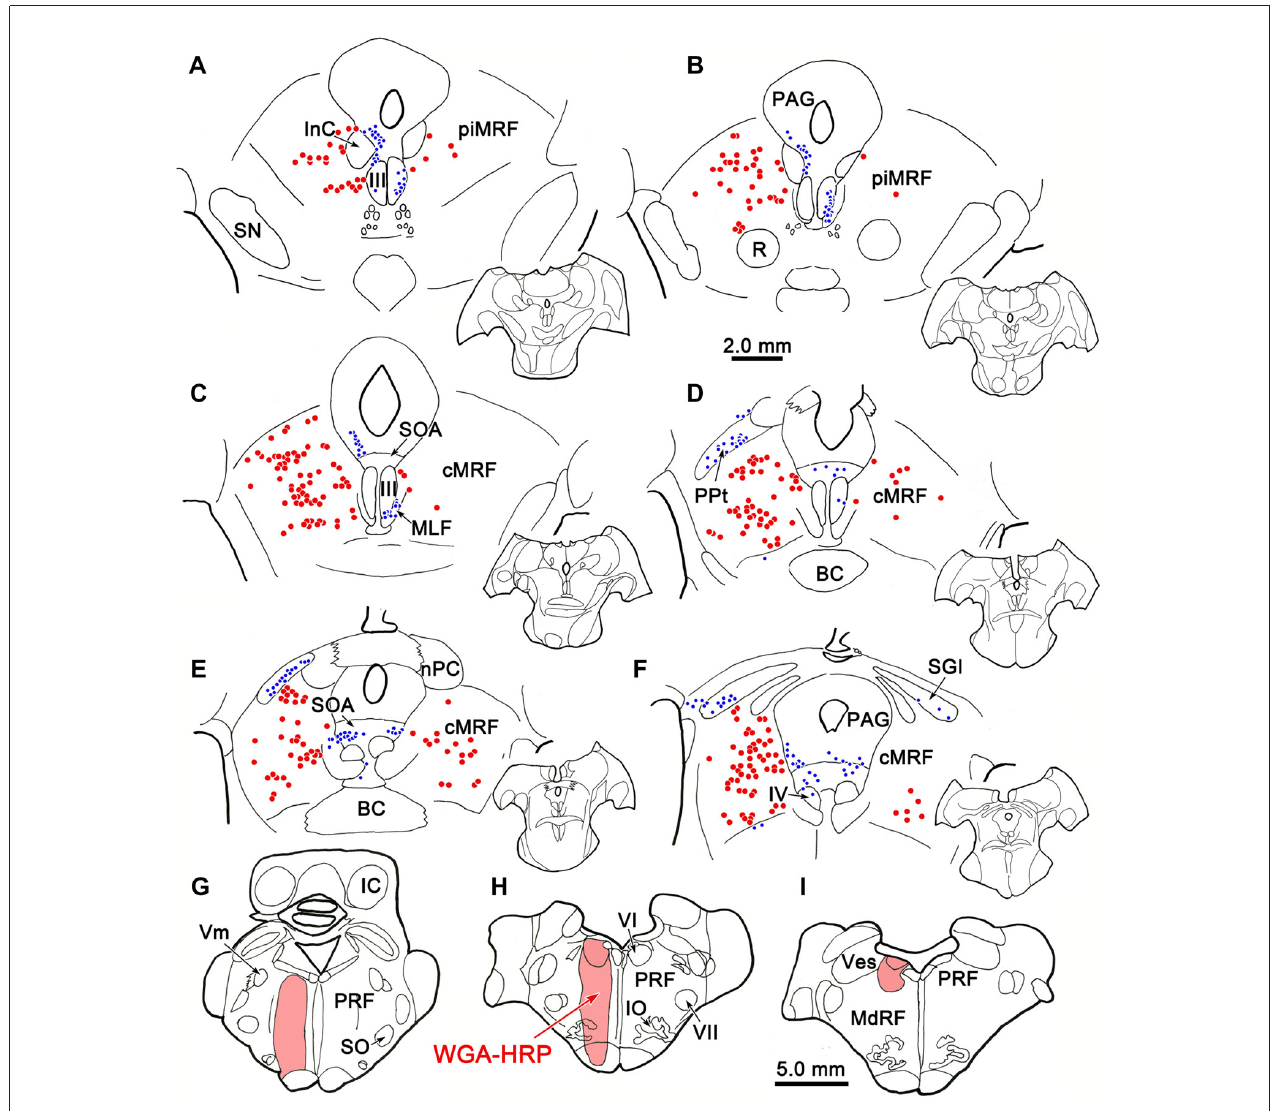
FIGURE 9 | Distribution of midbrain reticuloreticular neurons charted on a rostral to caudal series of sections. An injection of wheat germ agglutinin conjugated to horseradish peroxidase (WGA-HRP) centered in the PRF (G–I) labeled reticuloreticular neurons (red dots) in the cMRF (C–F) and the piMRF (A,B) , as well as other midbrain cells (blue dots). Note the primarily ipsilateral distribution. Adjacent insets show the level of the selected